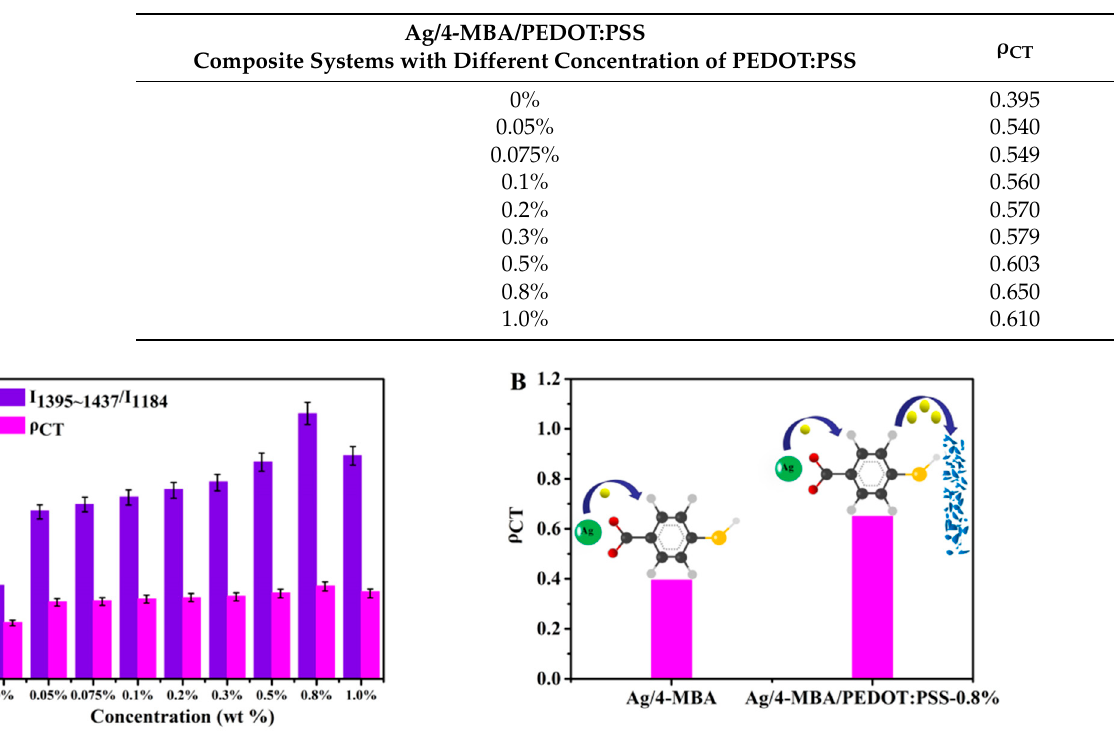
Figure 6. ( A ) Column chart of ρ CT values of the Ag/4-MBA/PEDOT:PSS composite system with different concentrations of PEDOT:PSS (0%, 0.05%, 0.075%, 0.1%, 0.2%, 0.3%, 0.5%, 0.8%, and 1.0%). ( B ) Column chart of ρ CT values of the Ag/4-MBA/PEDOT:PSS composite system (0.8% PEDOT:PSS) and Ag/4-MBA. When Ag, 4-MBA and PEDOT:PSS contacted each other, a new CT process occurred at the contact interface, and a new CT state formed. The Fermi energy level of Ag NPs in vacuum is − 4.84 eV [42], and the highest occupied molecular orbital (HOMO) and lowest unoccupied molecular orbital (LUMO) of 4-MBA have energies of − 8.48 eV and − 3.21 eV, respectively [43]. The HOMO and LUMO of PEDOT:PSS are − 6.20 eV and − 5.50 eV [44], respectively, and the band gap (E g ) is 1.80 eV. Figure 7 shows the CT process in the Ag/4- MBA/PEDOT:PSS composite system. Under 633 nm excitation, the incident light energy is 1.96 eV, the Fermi level of Ag is full of electrons, the electrons are excited to the LUMO level of the 4-MBA molecule, and the electrons will continue to transfer to the LUMO level of PEDOT:PSS because of the potential difference. An electron in the HOMO level of PE- DOT:PSS is excited to the LUMO level of PEDOT:PSS and then transferred to the LUMO level of the 4-MBA molecule. When the LUMO level of PEDOT:PSS is full of electrons, the LUMO level of PEDOT:PSS will increase, while the Fermi energy level of Ag will decrease until the Fermi levels of both sides are equal. In this case, the CT velocity in both directions is equal, and the SERS signal is stable [45]. For the Ag/4-MBA system, ρ CT ( κ ) is 0.395, which means that the EM is still dominant in the Ag/4-MBA system. By introducing PEDOT:PSS, the electron continues to transfer from the LUMO level of 4-MBA to the LUMO level of PEDOT:PSS, and the electron is excited from the HOMO level of PEDOT:PSS to the LUMO level of PEDOT:PSS and the LUMO level of 4-MBA, resulting in an increase in ρ CT ( κ ) from 0.395 to 0.650, which indicates a new CT process. The CT process has considerable effects on SERS enhancement, thus increasing the SERS intensity. Compared with the Ag/4-MBA system, the Ag/4-MBA/PEDOT:PSS composite system exhibits better SERS activity be- cause PEDOT:PSS increases the contributions of CT. Figure 7. CT mechanism in terms of the Ag/4-MBA/PEDOT:PSS energy level diagram.